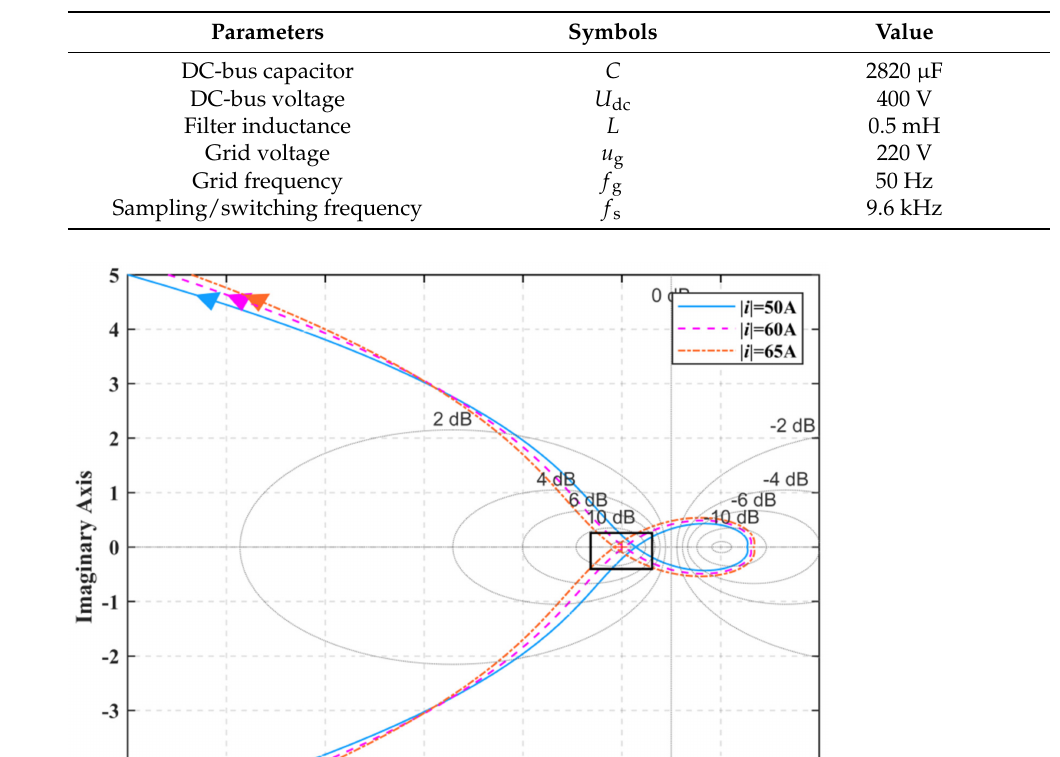
Table 2. Main parameters of the grid-tied converter system.